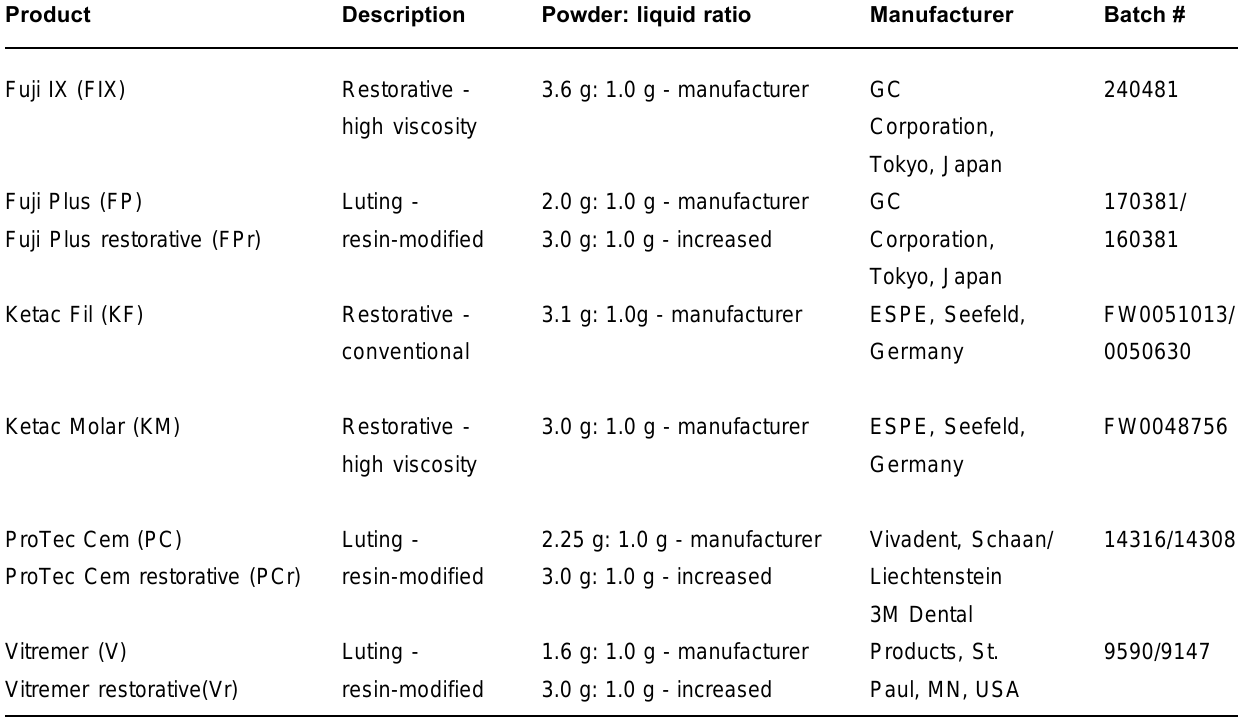
TABLE 1 - List of studied